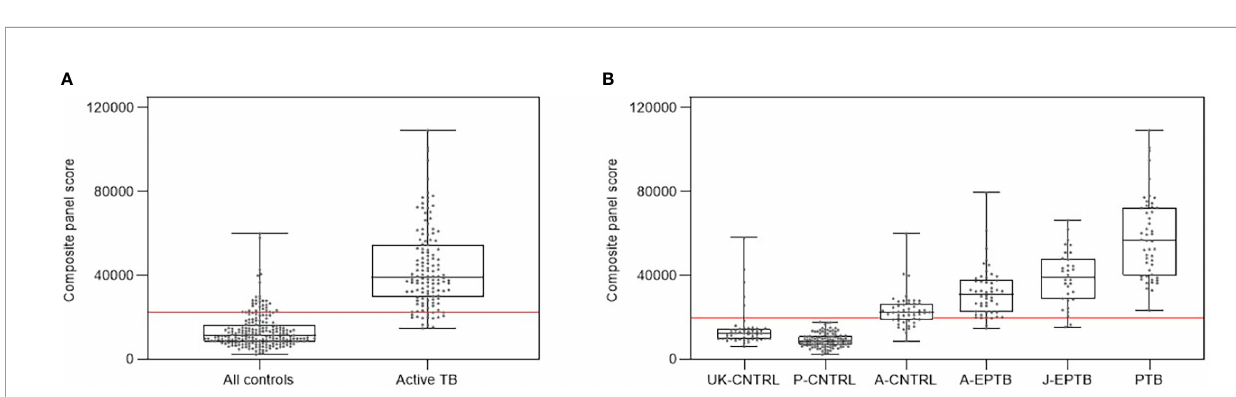
FIGURE 5 | (A) Combined box and scatter plot graphical depictions of composite panel score of the complex 6-plex biomarker panel between all controls and all active TB groups combined, displaying the cut-off value y=22361 for discrimination of all active TB groups from all controls with 90.1% sensitivity and 85.7% speci fi city (B) Combined box and scatter plot graphical depictions of expression of the complex 6-plex biomarker panel between individual control and active TB groups displaying the cut-off value y=19698 for discrimination of all active TB groups from all controls with 95.4% sensitivity and 81.3% speci fi